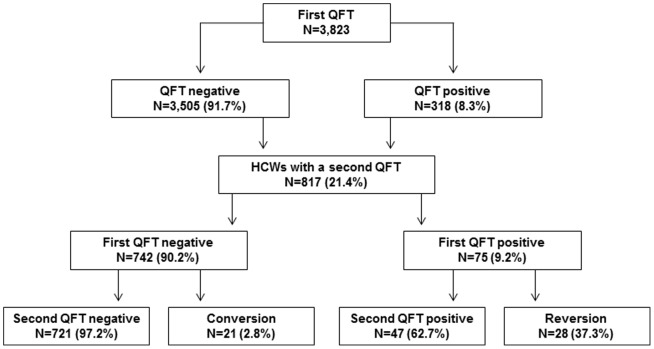
Flowchart: Study population and QFT results.